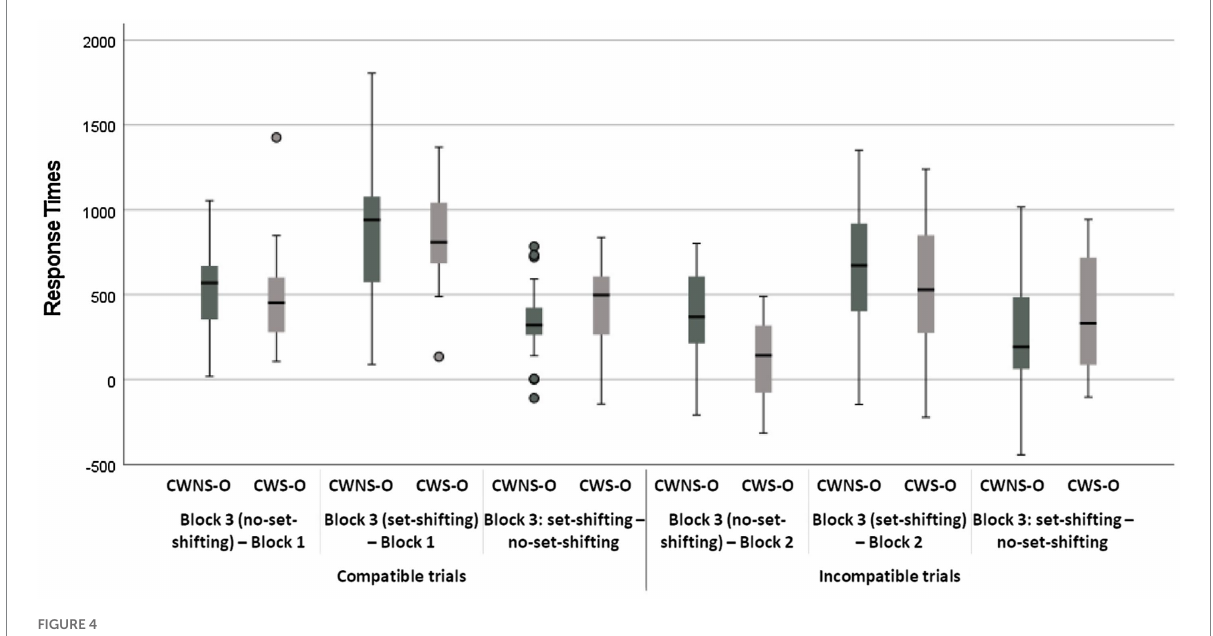
FIGURE 4 Boxplots of costs in response times for CWNS-O and